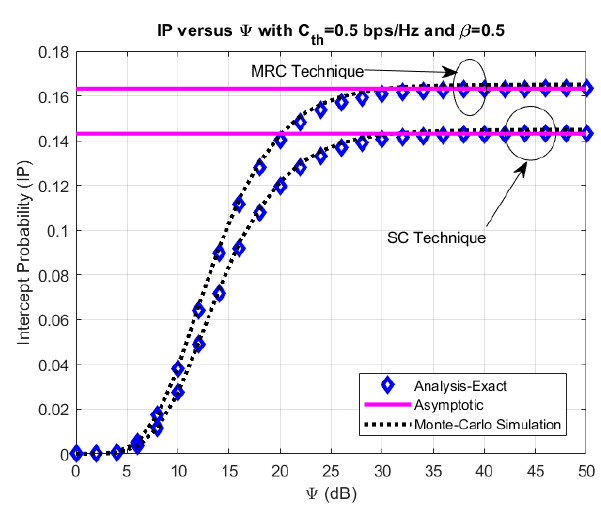
Figure 5. IP versus ψ .